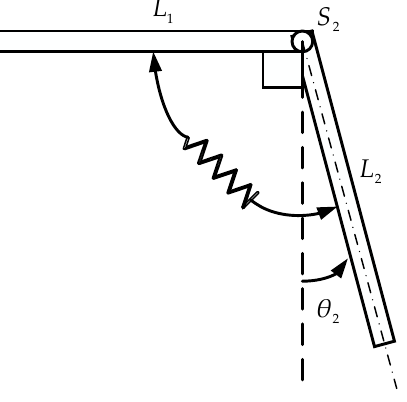
Figure 3. Schematic of joint model.